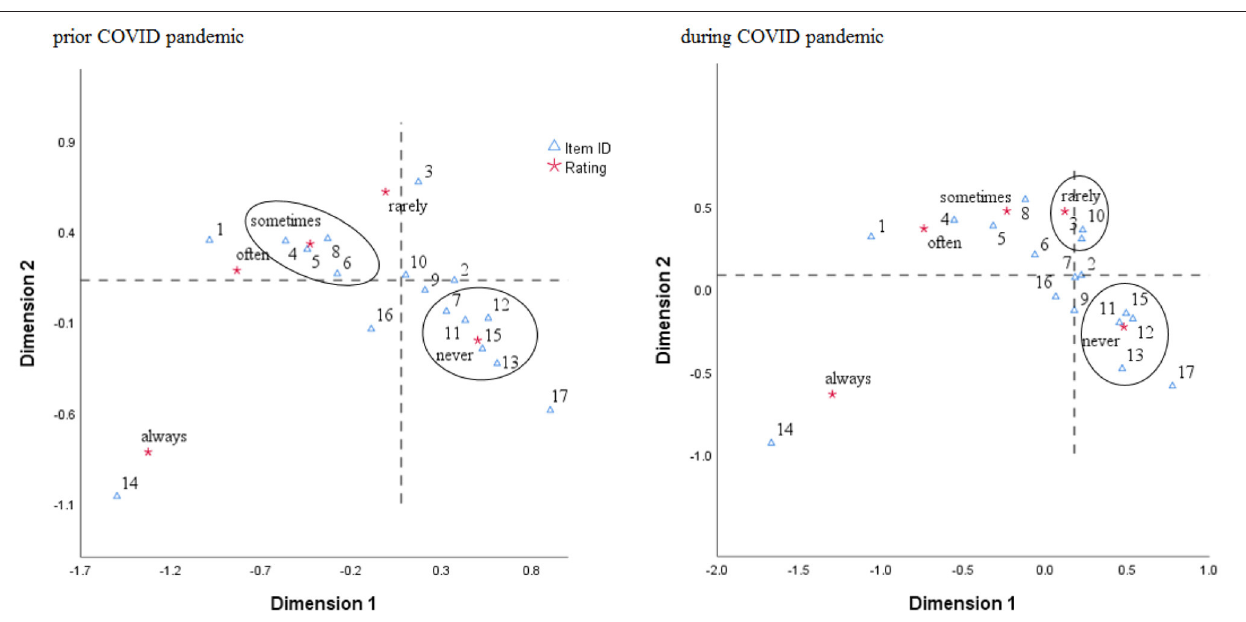
FIGURE 3 | The pattern of consumers’ behavior based on correspondence analysis. Source: authors’ calculation. Product types are coded as follows: 1, textile; 2, food; 3, DIY; 4, cosmetics; 5, books; 6, laptops; 7, courses; 8, electro; 9, advertisement; 10, sports; 11, toys; 12, auto; 13, pets; 14, utilities; 15, medicine; 16, tourism; 17,